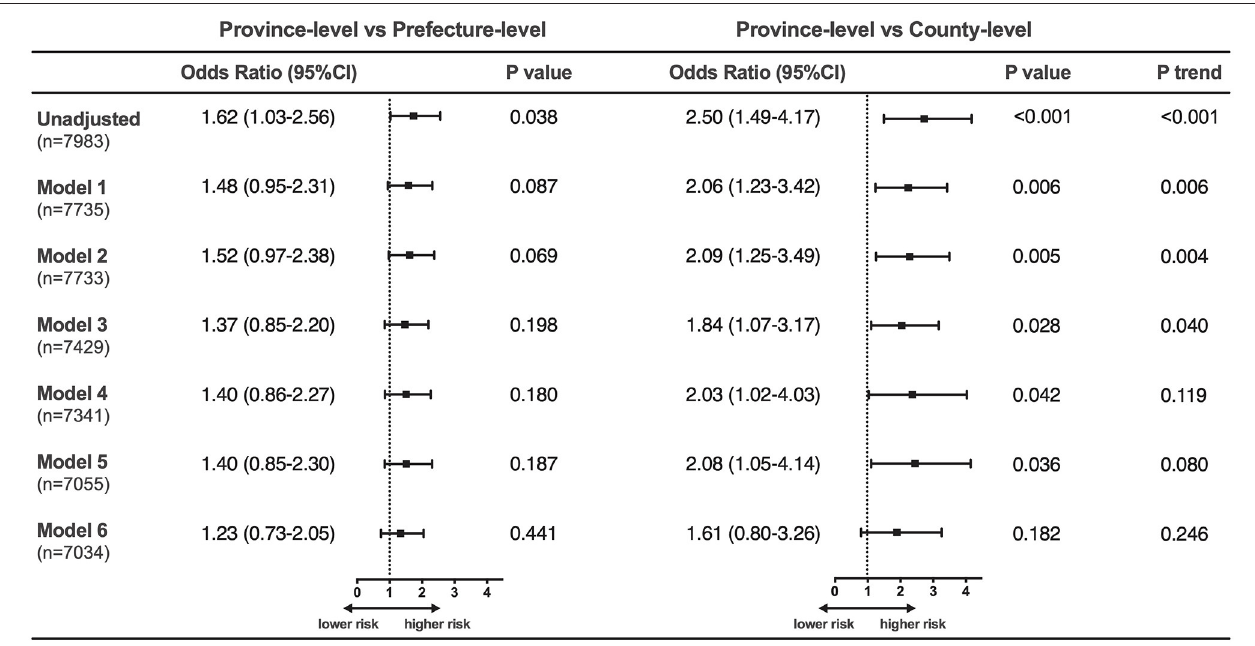
FIGURE 5 | Adjusted in-hospital mortality risk in patients with NSTEMI among the three hospital levels. Model 1 adjusting for patient characteristics (age, sex, hypertension, diabetes, prior myocardial infarction, prior heart failure); Model 2 adjusting for Model 1 plus medical contact (onset-to-arrival time, means of transport); Model 3 adjusting for Model 2 plus clinical status at admission (anterior-wall infarction, systolic blood pressure, heart rate, cardiogenic shock, heart failure, cardiac arrest, Killip class); Model 4 adjusting for Model 3 plus hospital facilities (coronary care unit availability, coronary catheter lab availability); Model 5 adjusting for Model 4 plus the use of medications (aspirin, P 2 Y 12 -receptor inhibitors, statin, β -blocker, angiotensin-converting enzyme inhibitor/angiotensin receptor blocker) and intra-aortic balloon pump; Model 6 adjusting for Model 5 plus the use of invasive